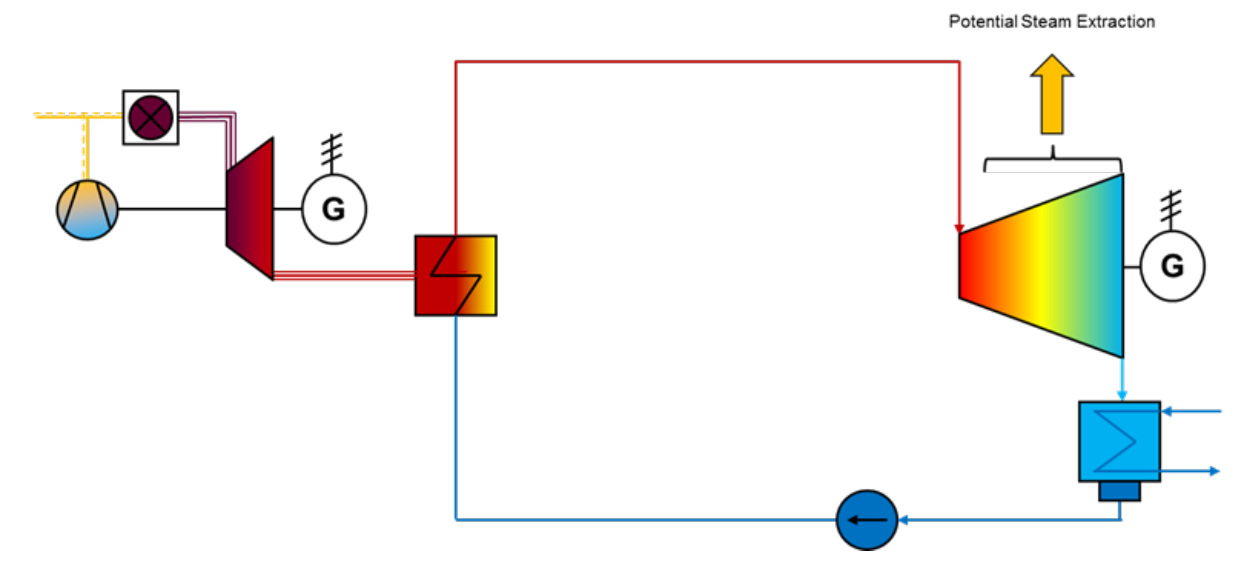
Figure 4. Single Pressure CHP Cycle (simplified).